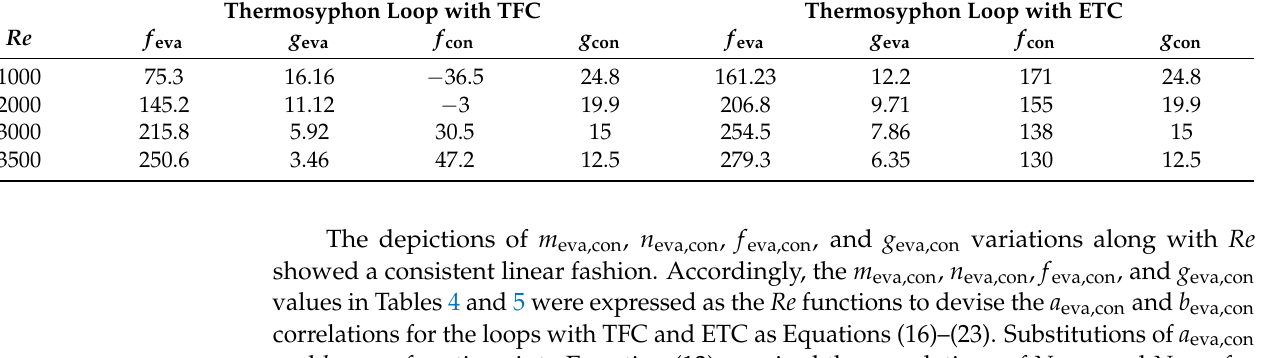
Table 5. Correlative coefficients of m eva,con and n eva,con in the b eva,con functions. Thermosyphon Loop with TFC Thermosyphon Loop with